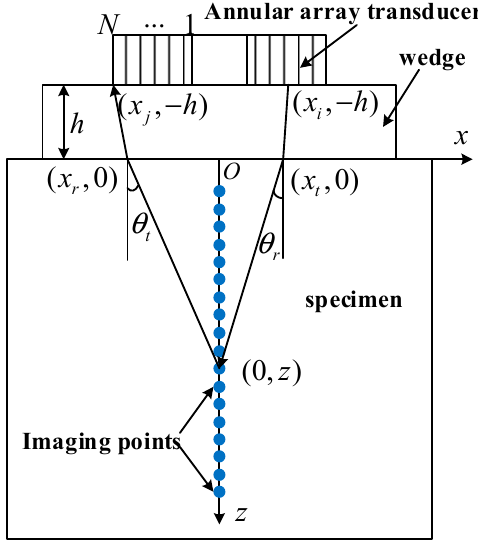
Figure 3. The testing method of total focusing imaging for the annular array transducer.